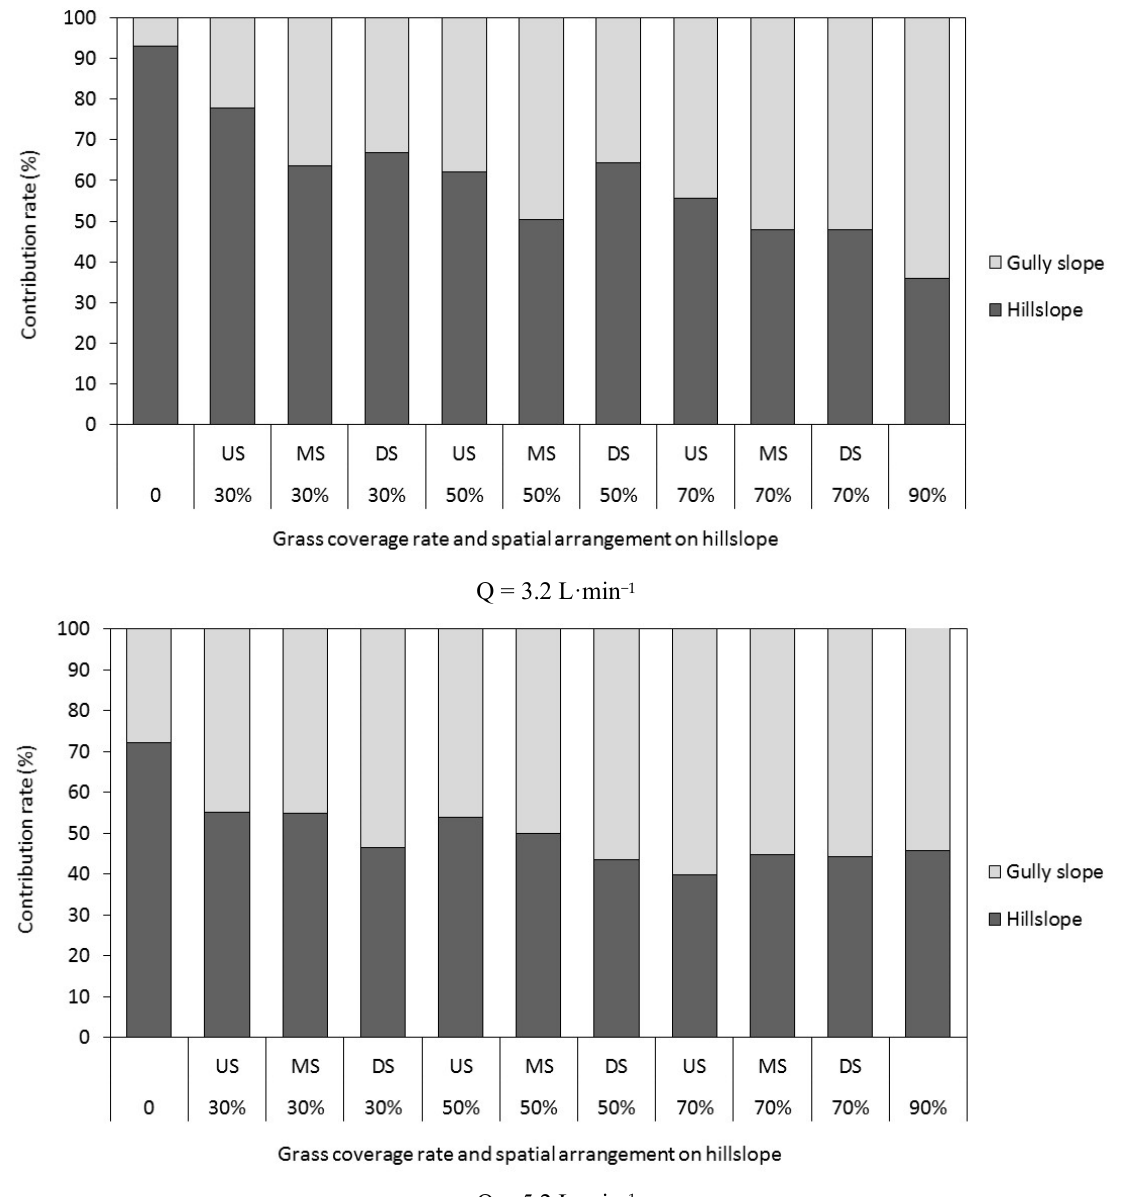
Figure 4. Contributions of the hillslope and the gully side to erosion reductions of the slope-gully erosion system.